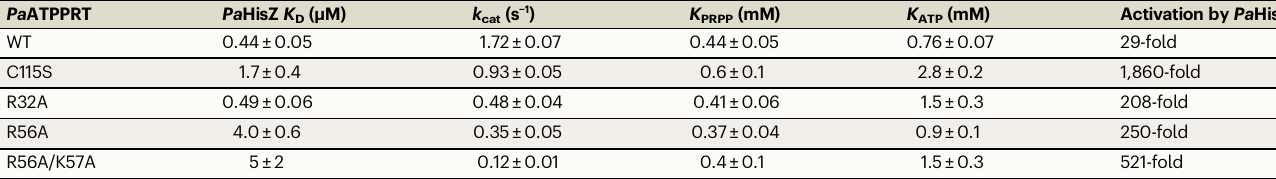
Table 2 | Apparent steady-state kinetic parameters (mean± fi tting error) for Pa ATPPRT variants (all mutations are in Pa HisG S ) Pa ATPPRT